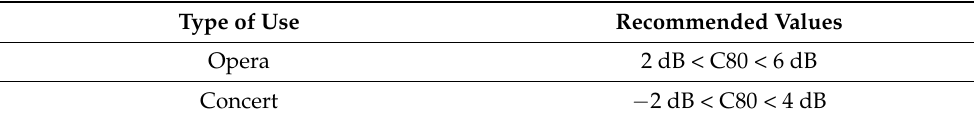
Table 8. Recommended values of clarity (C80), suggested by Arau [33], depending on the type of use of the space.